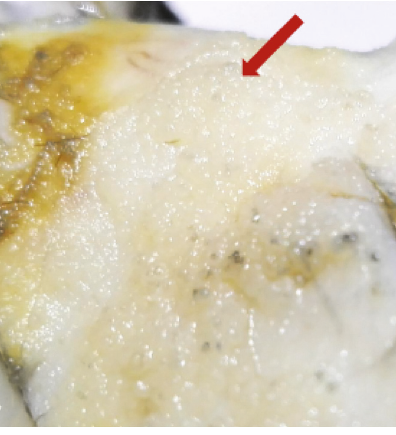
Figure 2: Blunt pale projections on an otherwise smooth cyst wall.